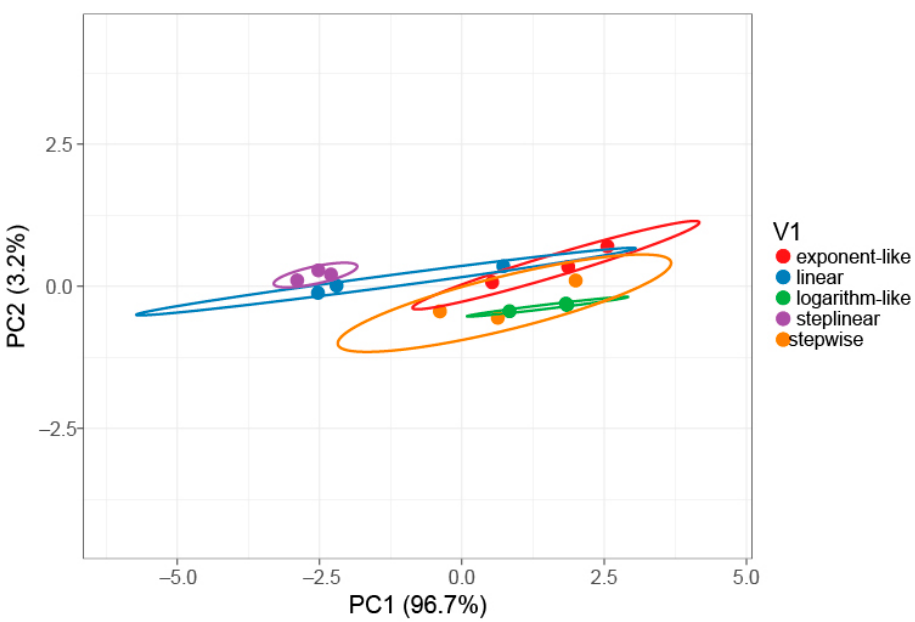
Figure 2. PCA plot of five different gradient types. Prediction ellipses represent the 95% confidence interval. PCA analysis was performed using the ClustVis tool [26]. The PCA was blinded to four sets of data, namely protein groups identified using MSFragger (MSFragger_PG), protein groups (PG) identified using PEAKS Studio (PEAKS_PG), unique spectral counts (USC) from MSFragger output (MSFragger_USC), unique spectral counts from PEAKS Studio (PEAKS_USC) (Table S1).